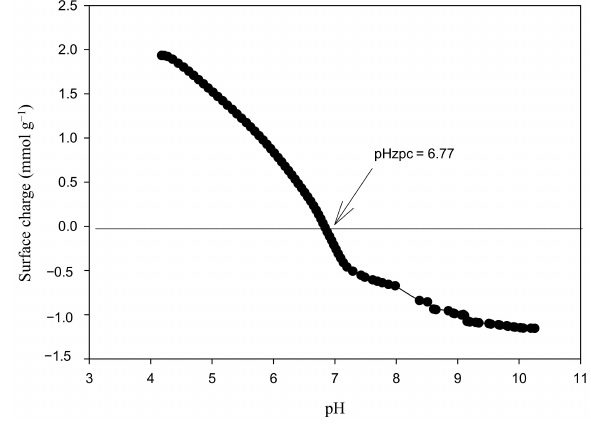
Figure 4. Proton binding curve of MCP. The FTIR spectrum for CS displays the characteristic bands at 3260 cm − 1 assigned to the stretching of the amine, which correlates to the stretching movement of the carbonyl group in the amide chitin bond, 1578 cm − 1 , that concurs with the vibration flexion of methyl in the acetamide group (Figure 5). The characteristic stretching vibrators of PCL were asymmetric and symmetric CH 2 , carbonyl, and C-O-C in the crystalline phase at 2944 cm − 1 , 2865 cm − 1 , 1720 cm − 1 , and 1293 cm − 1 , respectively (Appendix C) [38]. The bands assigned to the amide and amine groups of CS did not decrease in intensity in the FTIR spectrum for MCP. This concludes that these groups did not interact with PCL during the extrusion process and remain available for the adsorption of metal ions.